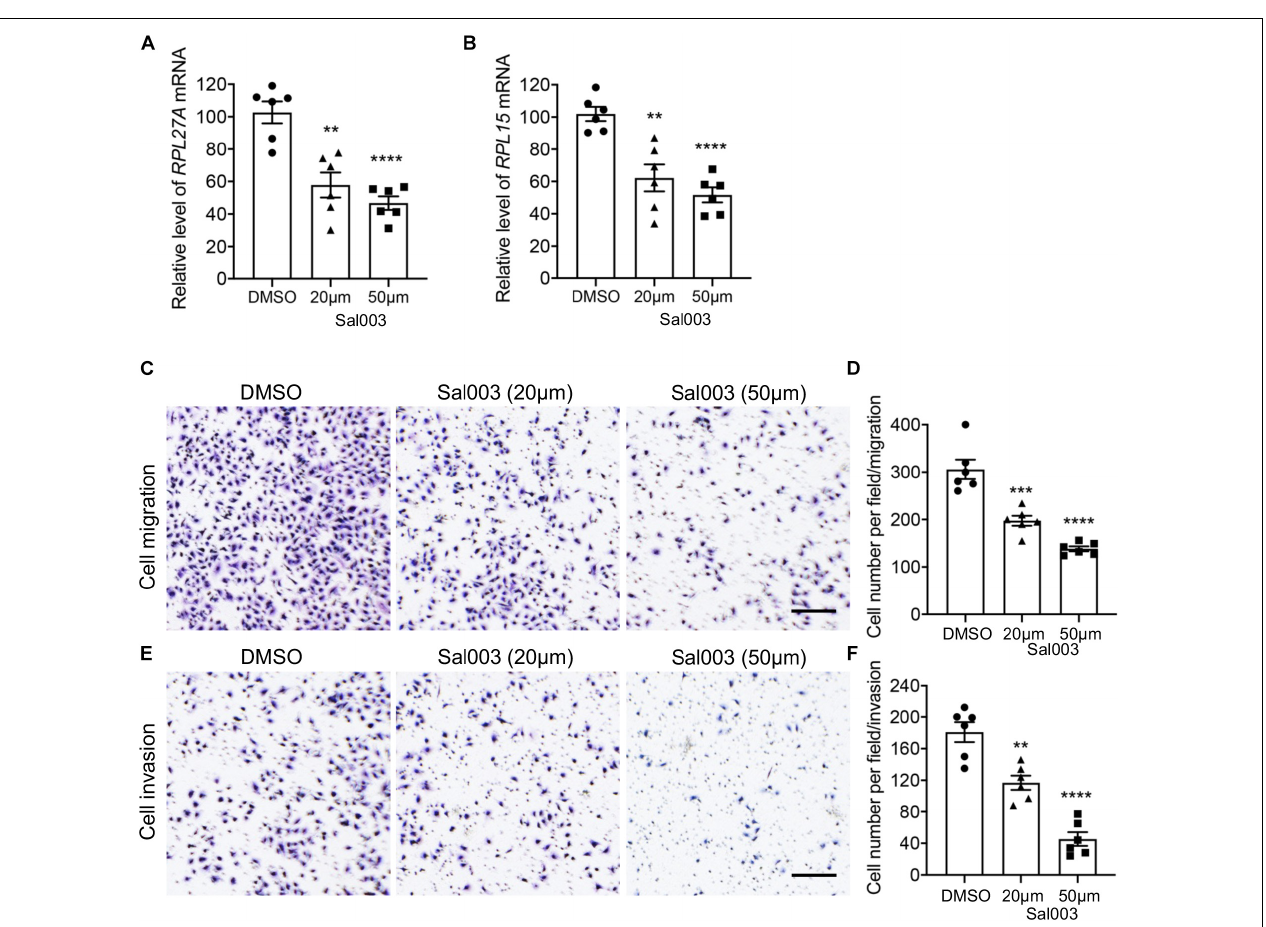
FIGURE 8 | Blocking EIF2 signaling decreased TNBC cell migration and invasion. (A,B) mRNA levels of RPL27A and RPL15 in MDA-MB-231 cells after treatment of different doses of the EIF2 signaling inhibitor Sal003. (C,E) Representative images of migration (C) and invasion (E) assays on MDA-MB-231 cells after treatment of different doses of Sal003 or DMSO control. (D,F) Quantification of cell numbers in each image of migration (D) and invasion (F) assays. Scale bar, 50 µ m. ** p < 0.01; *** p < 0.001; **** p < 0.0001.